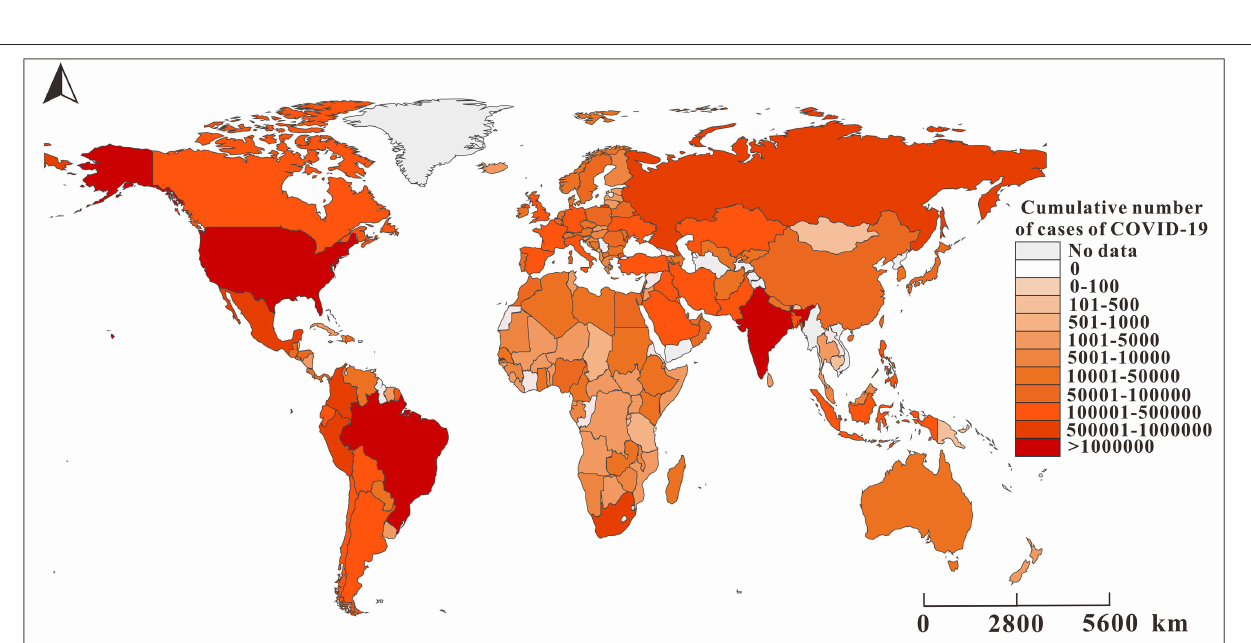
FIGURE 3 | The reported cumulative number of cases of COVID-19 in 160 countries as of August 22, 2020. The map depicted in these figures were taken from Wikimedia Commons (http://commons.wikimedia.org/wiki/Main_Page).